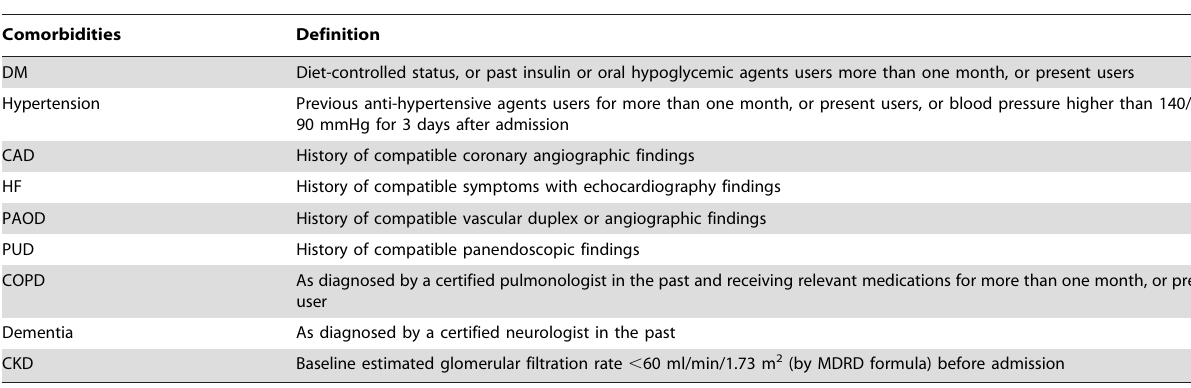
Table 1. Definitions of comorbidities used in the current study.